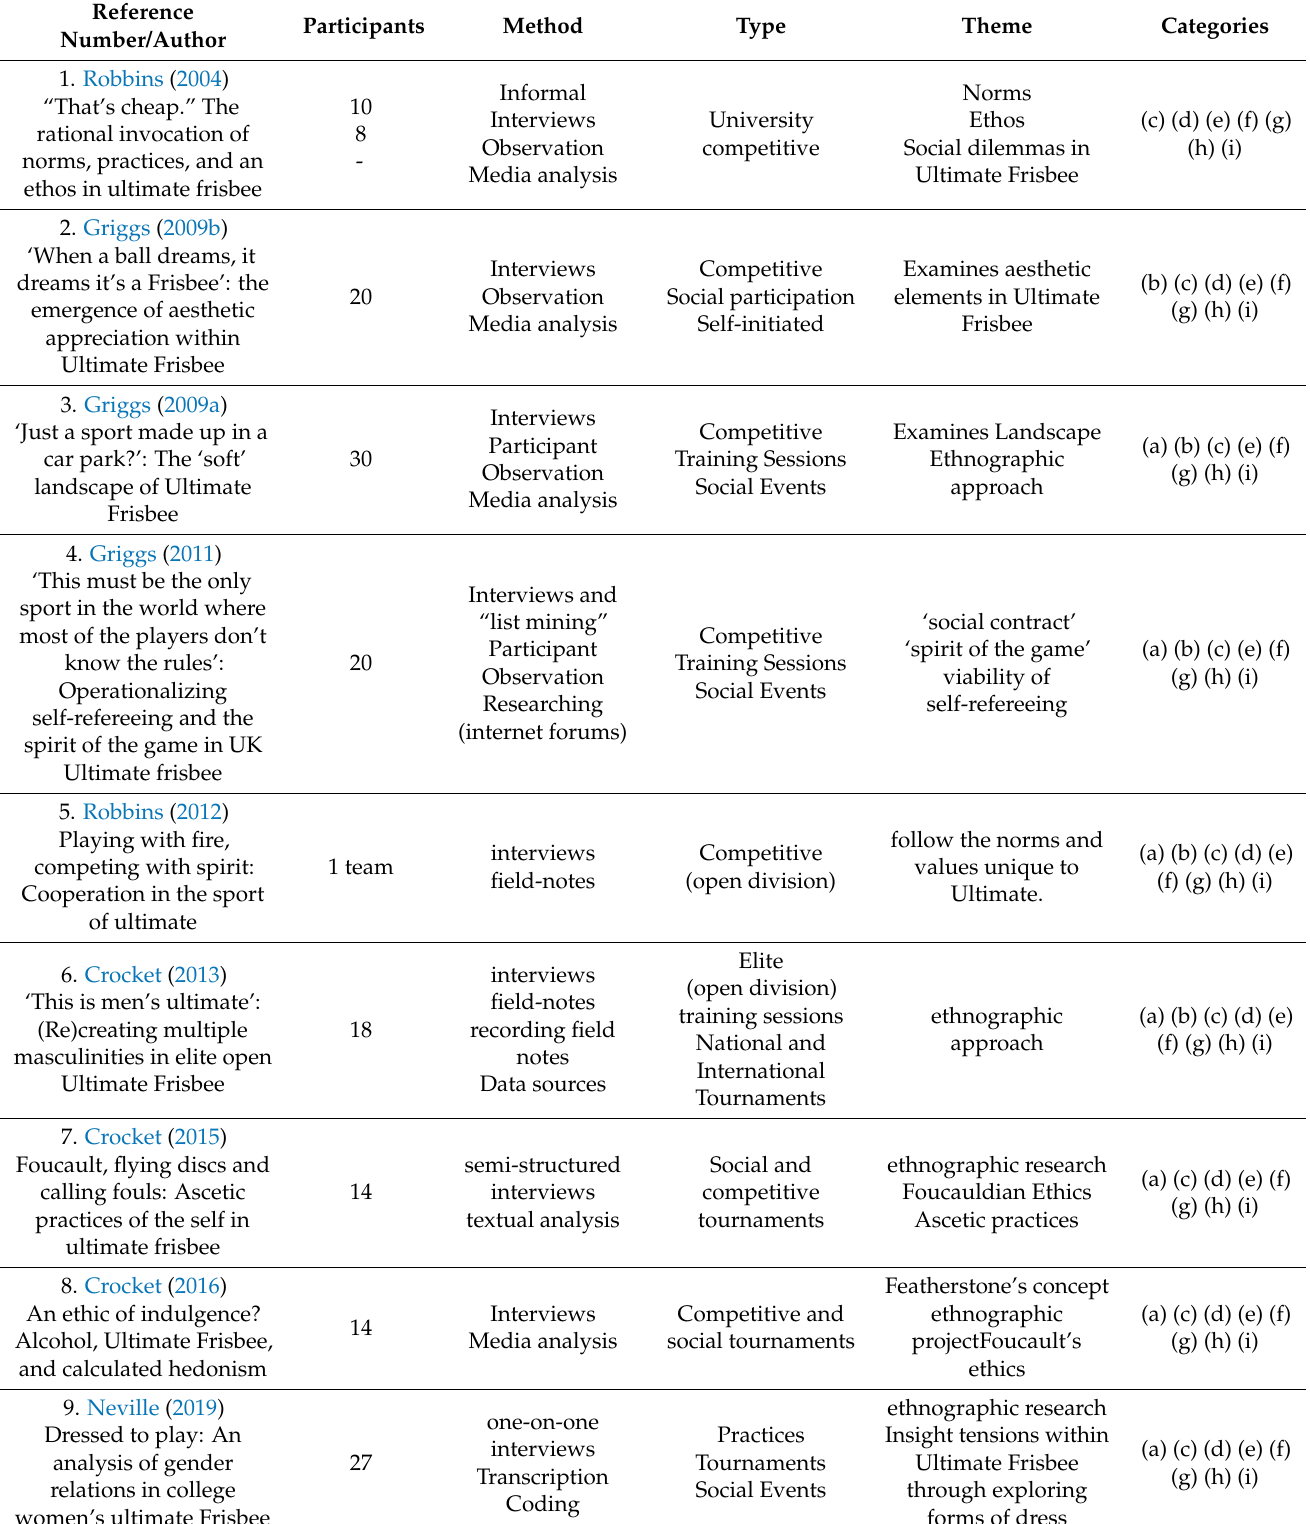
Table 2. Methodological characteristics of the included studies in the review (n =